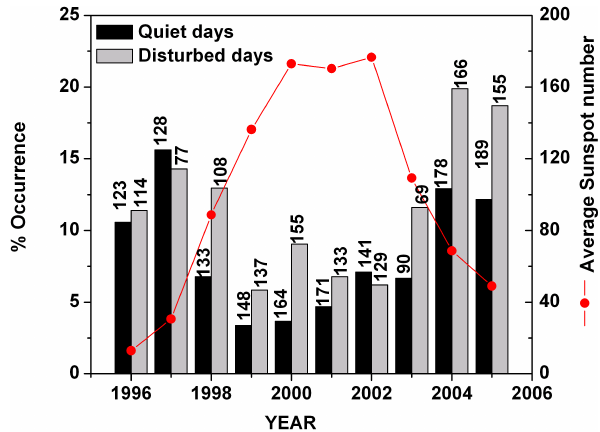
Fig. 2. Solar cycle variation of the F3 layer during quiet and dis- turbed times from 1996–2005. The total number of days on which data was available is written on top of each histogram.